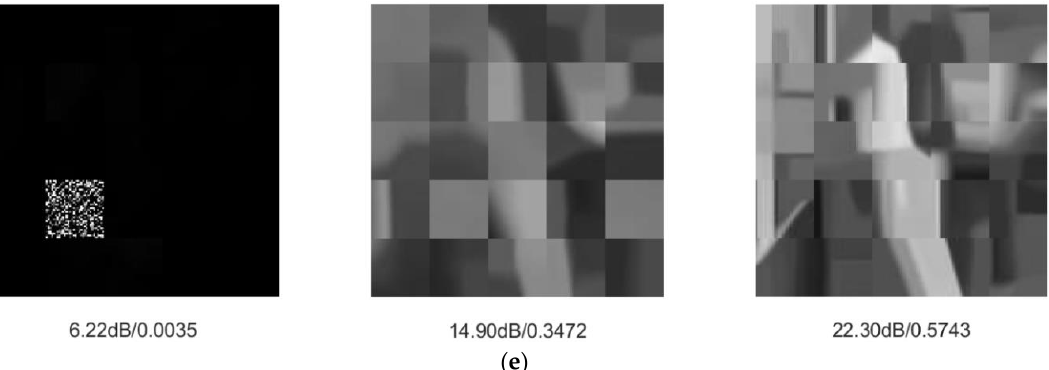
Figure 6. Visual comparisons of WallPushups_g20 . ( a ) JsrNet, ( b ) Reconnet, ( c ) MH-BCS-SPL, ( d ) FIR, ( e ) D-AMP. SR = 0.01 N